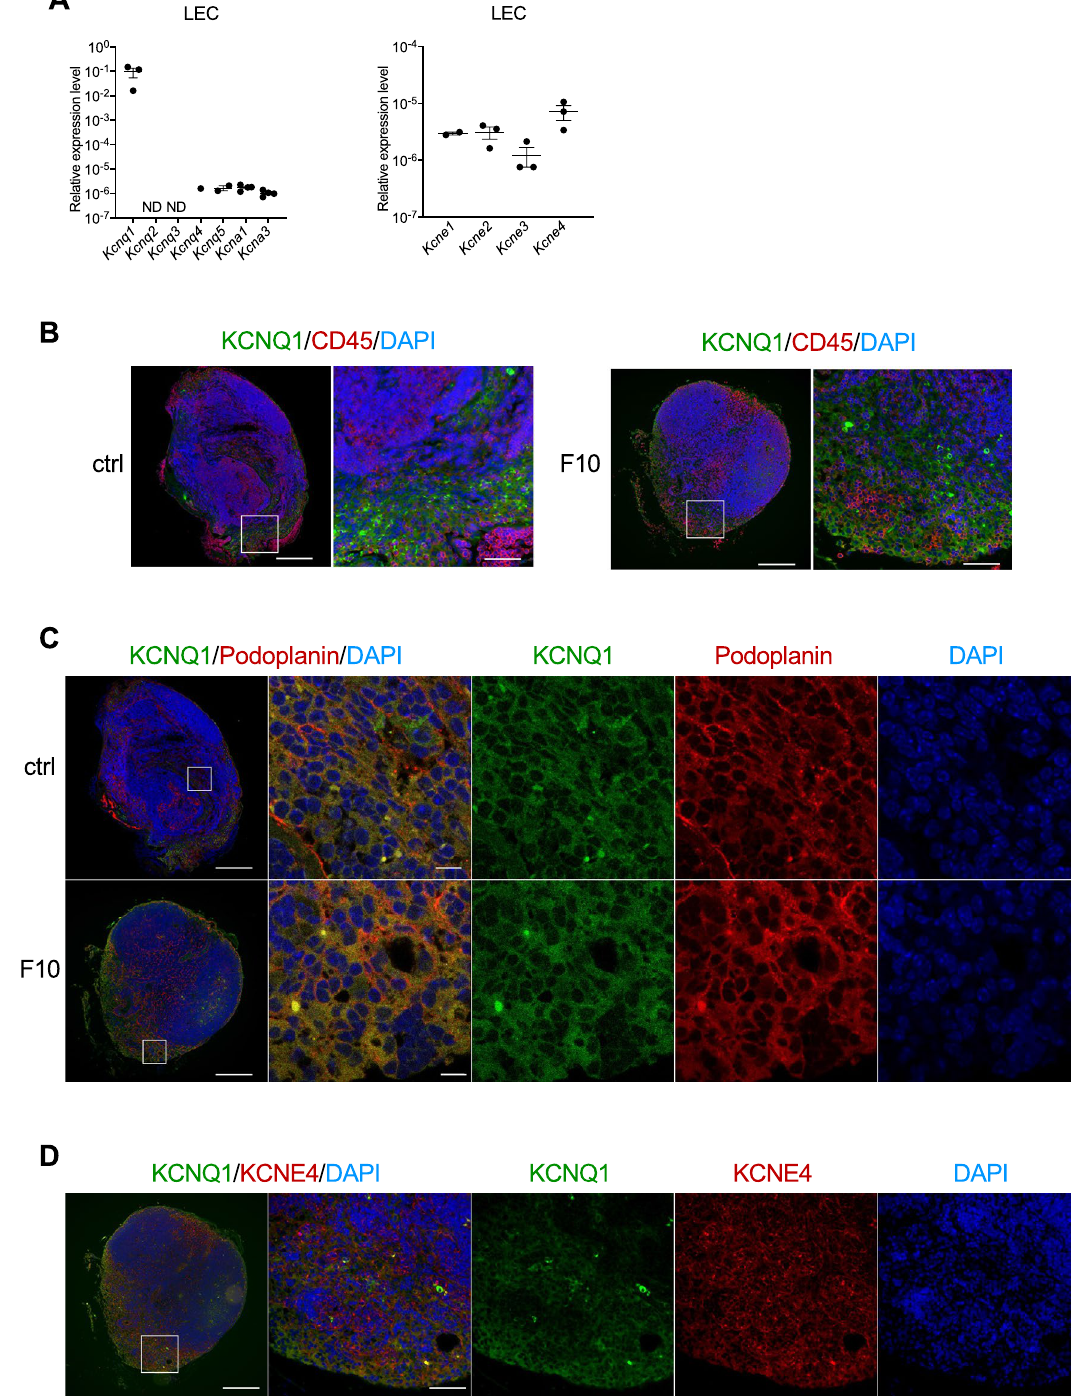
Figure 4. Expression of KCNQ1 and KCNE4 in SLNs. ( A ) Expression of Kcnq family members and Kcna1 and Kcna3 in primary cultured LECs were examined by qRT-PCR. The expression of KCNQ1 in SLNs was analyzed by immunostaining. Double staining of KCNQ1 and CD45 ( B ), Podoplanin ( C ), and KCNE4 ( D ) was performed. Bars: 200 µm and 50 µm ( B,D ), 200 µm and 10 µm ( C